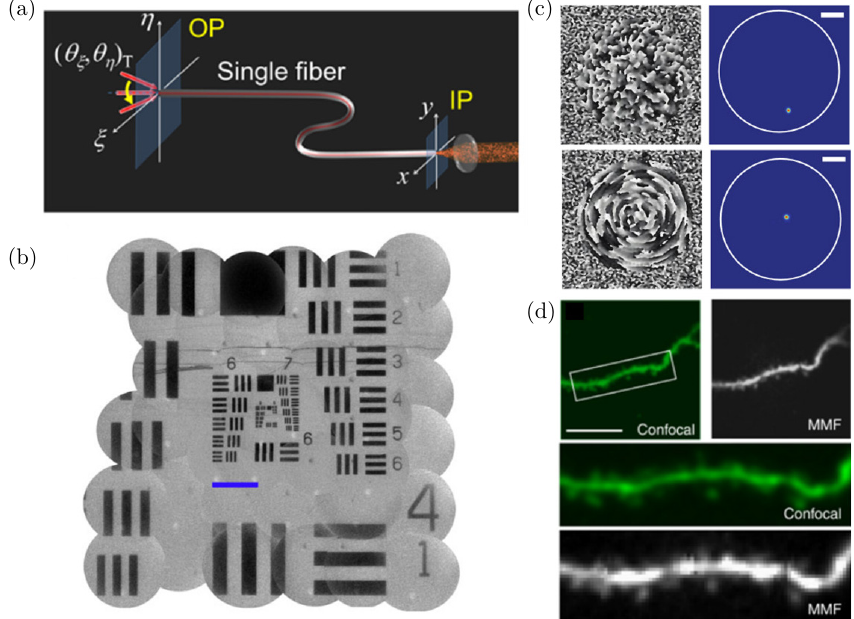
Fig. 4. Imaging through multimode ¯bers. (a) A multimode ¯ber scrambles input modes into multiple output modes in analogy with turbid media. Therefore, the transmission matrix connecting the input and output modes of the ¯ber can be calibrated, (b) The transmission matrix can be used to transform a multimode ¯ber into a wide¯eld microscope. 90 Scalebar 100 (cid:1) m , (c) The trans- mission matrix information can be also used to focus light to speci¯c positions beyond the multimode ¯ber. 81 Scalebar 20 (cid:1) m (Left: Phase of incident wavefront. Right: Obtained focus after propagation through multimode ¯ber) and (d) Scanning the focus can be used to realize °uorescence imaging. Comparison between confocal microscope and multimode ¯ber imaging in a living mouse brain. 93 Scalebar 20 (cid:1) m . Figures (a) – (b) reprinted with permission from Ref. 90, (c) from Ref. 81, and (d) from Ref.